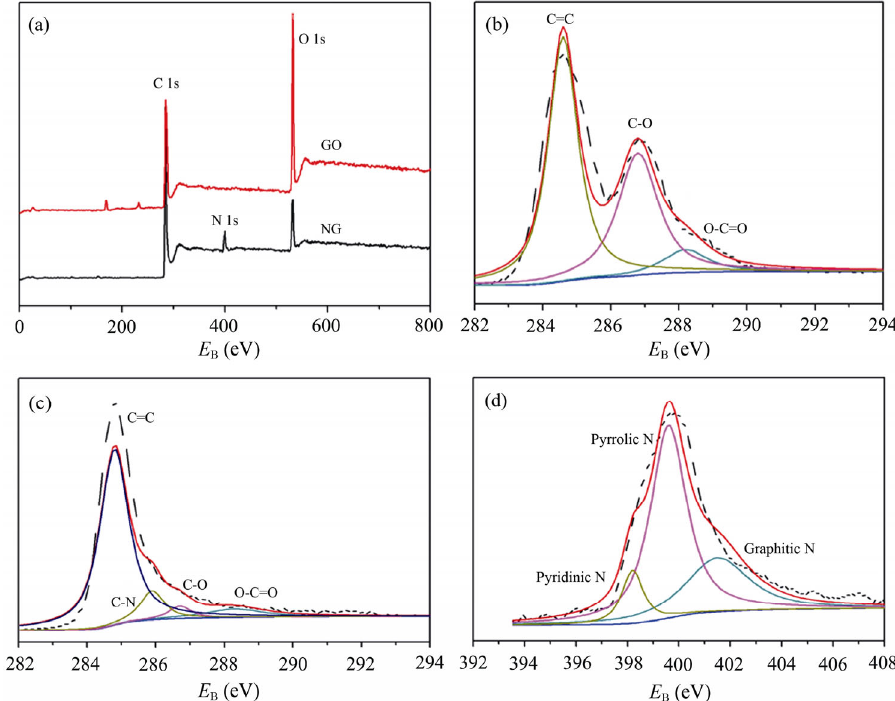
Fig. 2 (a) XPS full spectra of GO and NG; (b) and (c) high-resolution C 1s XPS spectra of GO and NG respectively; (d) high-resolution N 1s XPS